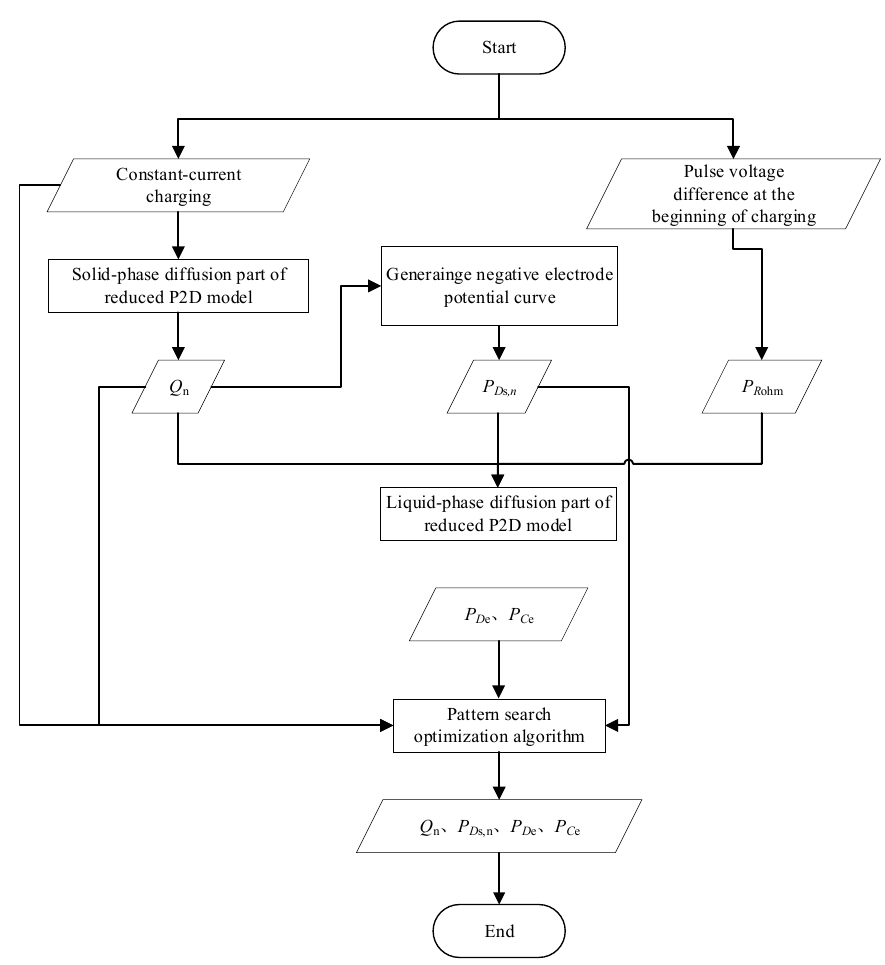
Figure 6. The flowchart of fast identification procedures for micro-health parameters ( Q n , P D s , P D e , P C e ).